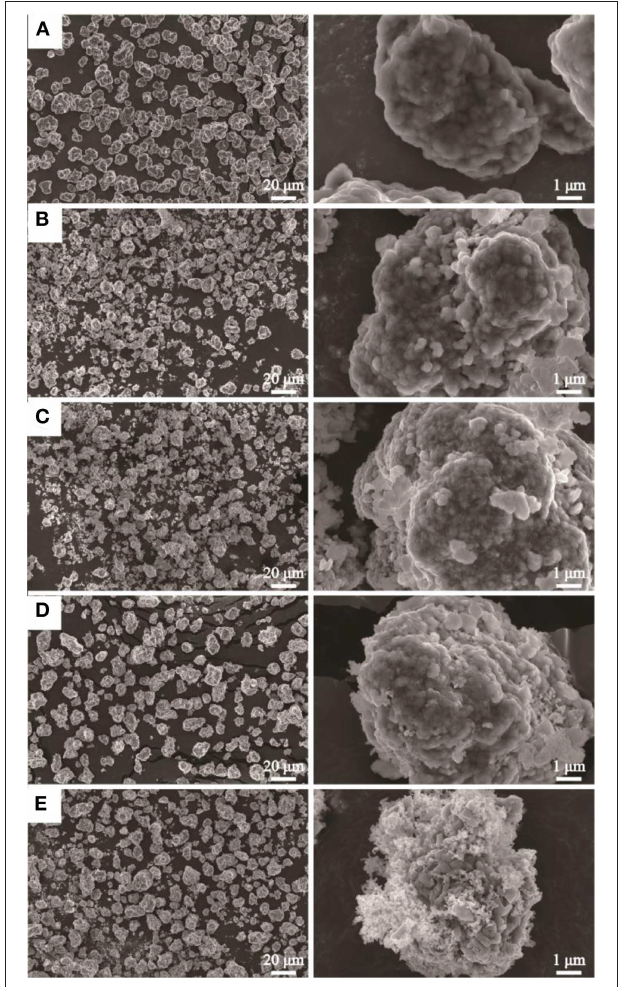
FIGURE 2 | SEM images of 811 (A) and nano SnO 2 -modified samples ( B : 1 wt%; C : 2 wt%; D : 3 wt%; E : 4